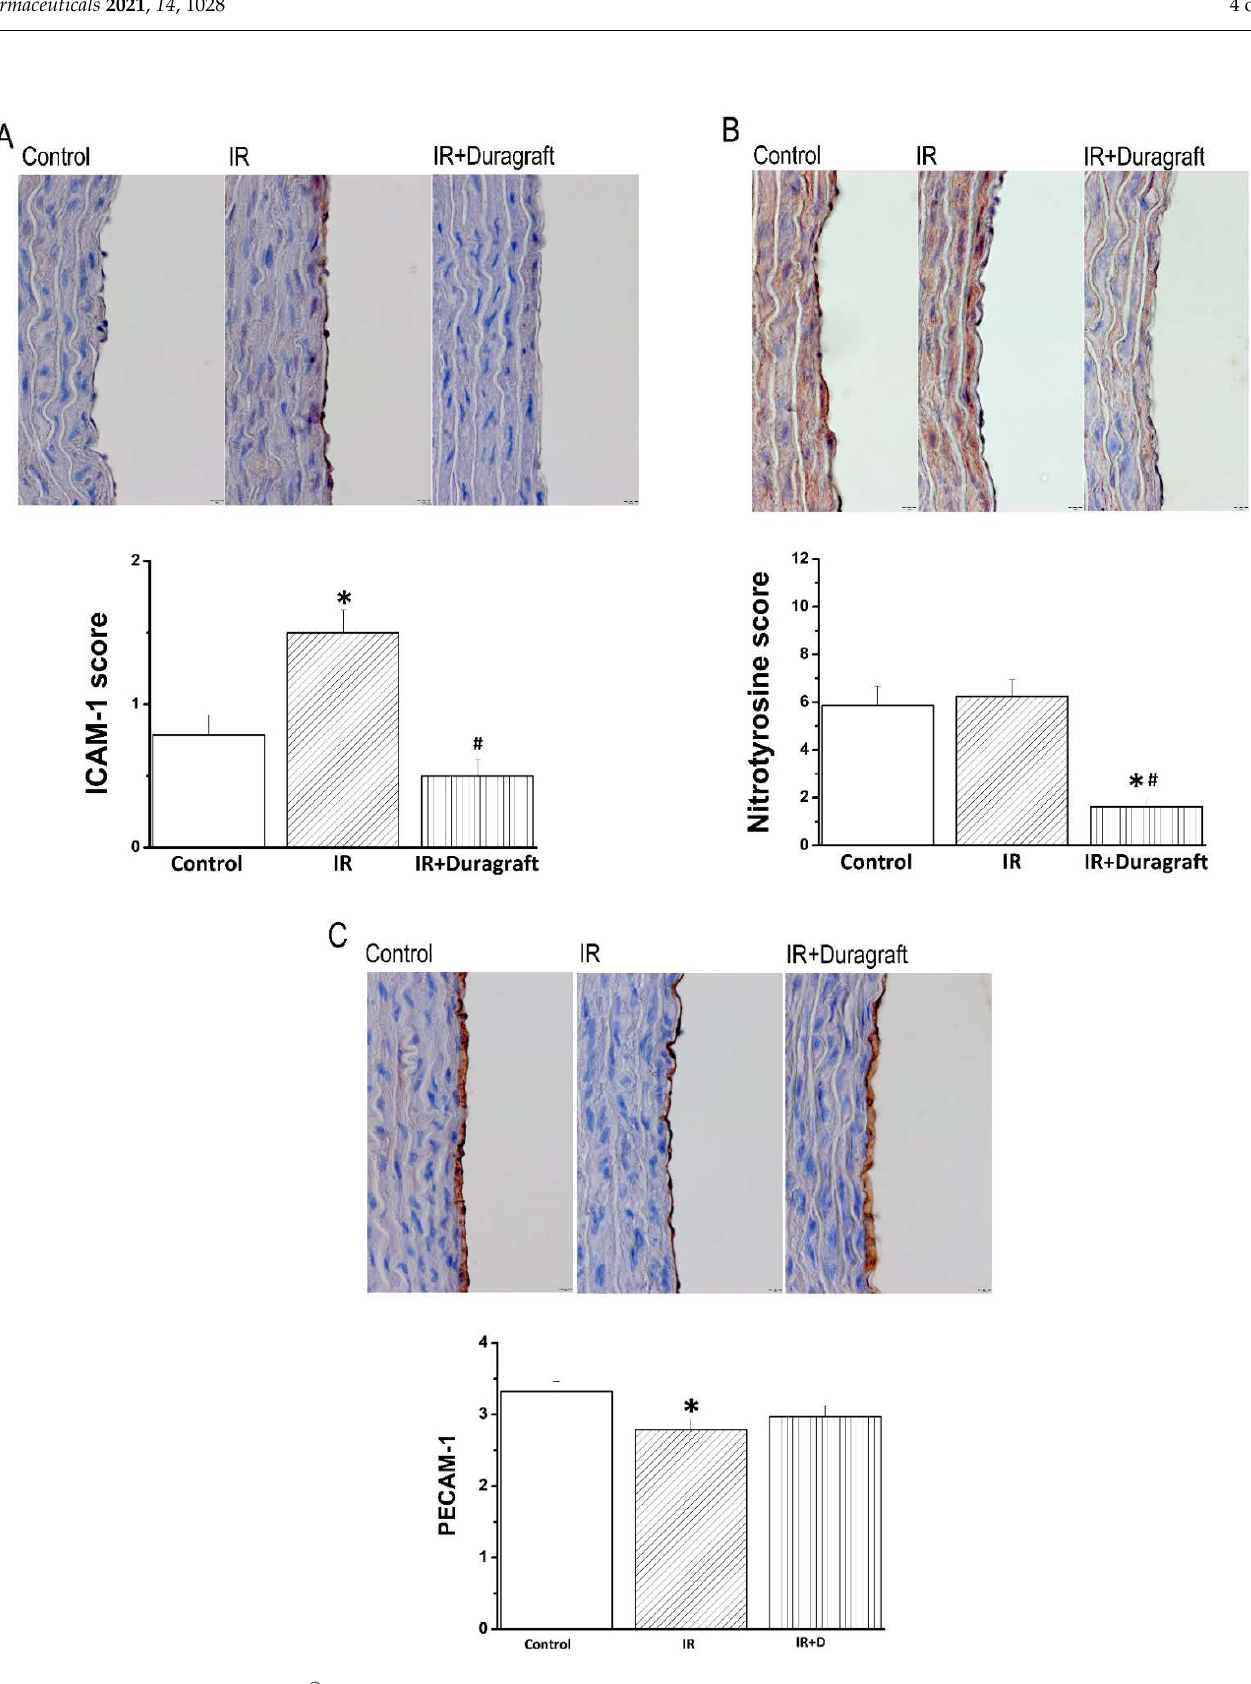
Figure 2. Effect of DuraGraft® on aortic intercellular adhesion molecule (ICAM)-1, nitrotyrosine, and platelet endothelial cell adhesion molecule (PECAM)-1 expression after vascular ischemia/reperfusion (IR) injury. Semi-quantitative scoring of ( A ) ICAM-1, ( B ) nitrotyrosine, and ( C ) PECAM-1 immunohistochemical staining and representative micrographs ( × 400, scale: 10 µm). Results are represented as mean ± SEM. * p < 0.05 versus control; # p < 0.05 versus IR. n = 24 – 28 aortic rings from 6 – 7 rats/group.